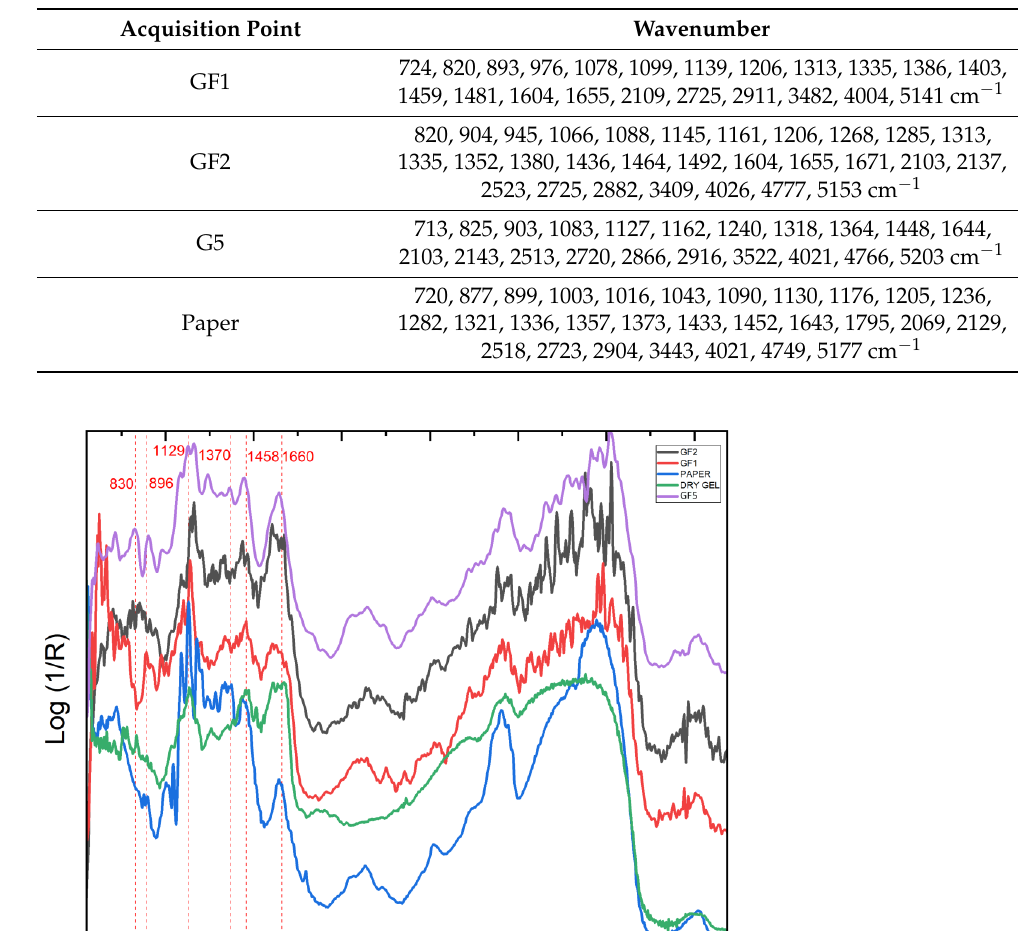
Table 4. Bands of the FTIR spectra of points GF1, GF2, G5, and paper.